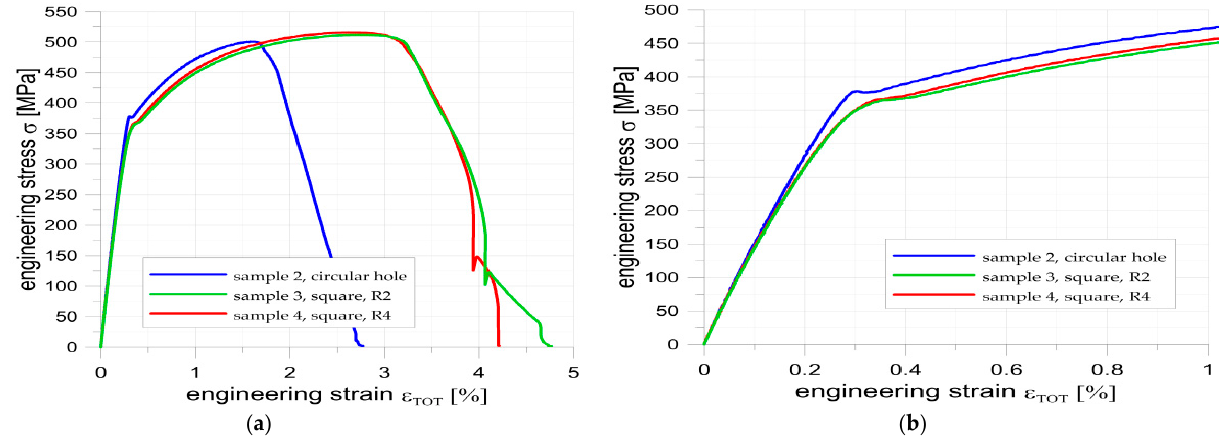
Figure 9. Engineering stress–strain curve for samples 2–4 made of S355J2+N with cut-outs: ( a ) behavior in full range of strain; ( b ) enlargement of initial range of strain.